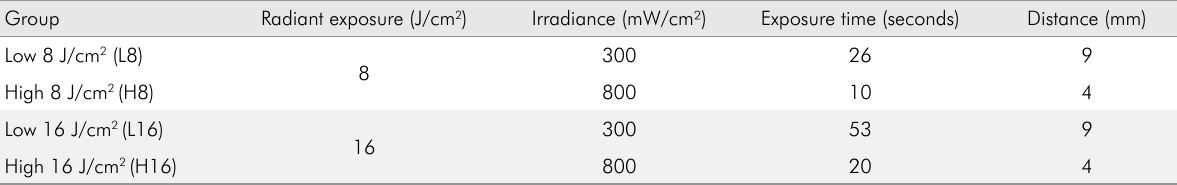
Table 1. Experimental groups evaluated. Group Radiant exposure (J/cm 2 ) Irradiance